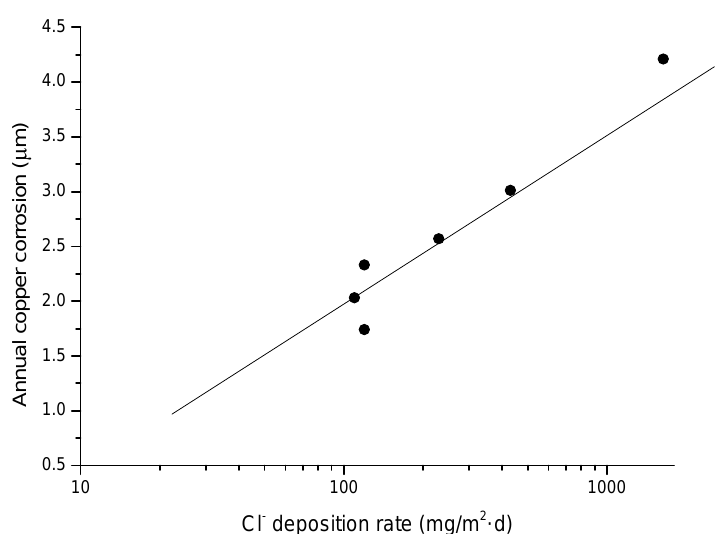
Figure 3. Representation of the variation in annual copper corrosion with the atmospheric chloride deposition rate.